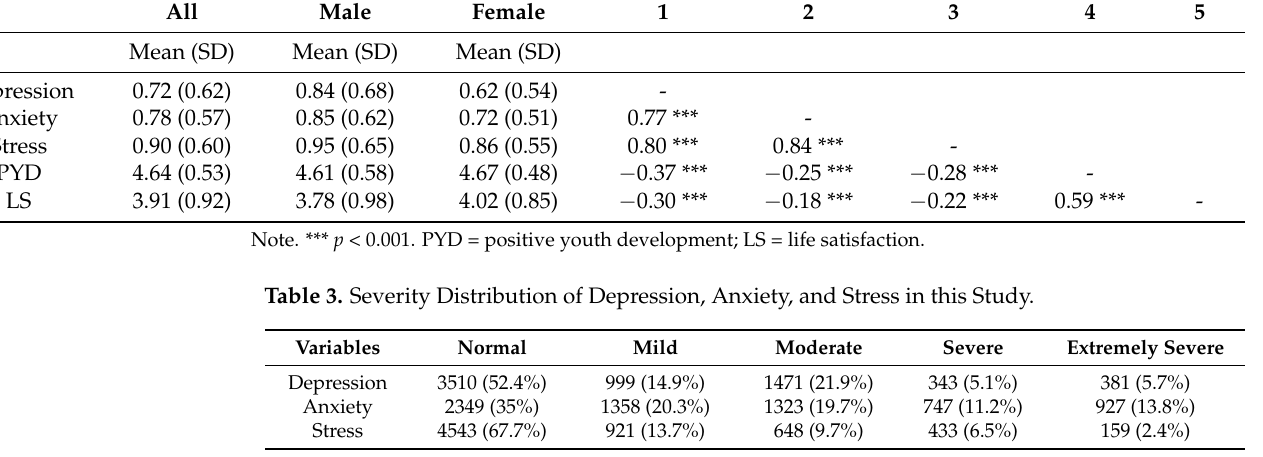
Table 2. Means, Standard Deviations, Reliabilities, and Correlations of Study Variables in this Study. All Male